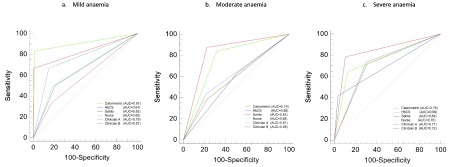
Receiver operating characteristic (ROC) curves for different methods used in the study.The figure shows the area under the receiver operator characteristic (ROC) curve for different Hb determining methods against HemoCue the gold standard with respect to three classifications of anaemia:
a) mild,
b) moderate, and
c) severe. The area under the curve captures the relationship between the sensitivity and specificity of each method against the gold standard.